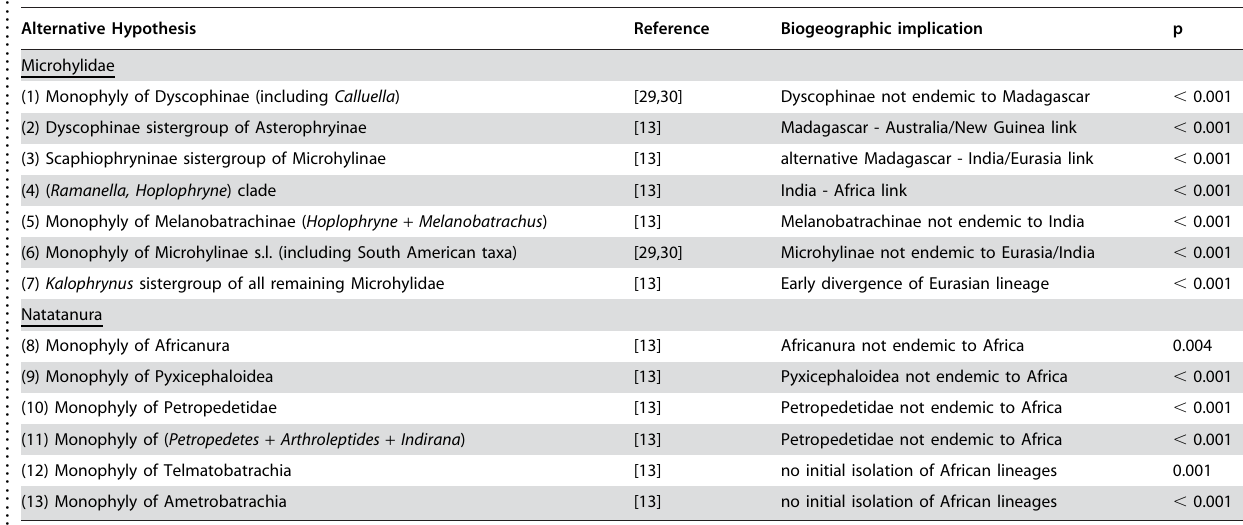
Alternative Hypothesis